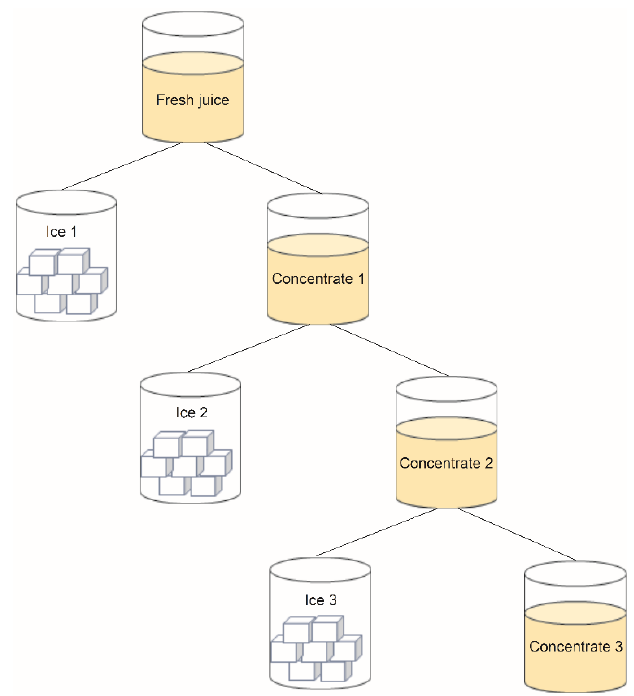
Figure 2. General centrifugal-assisted BCC protocol using three consecutive cycles.